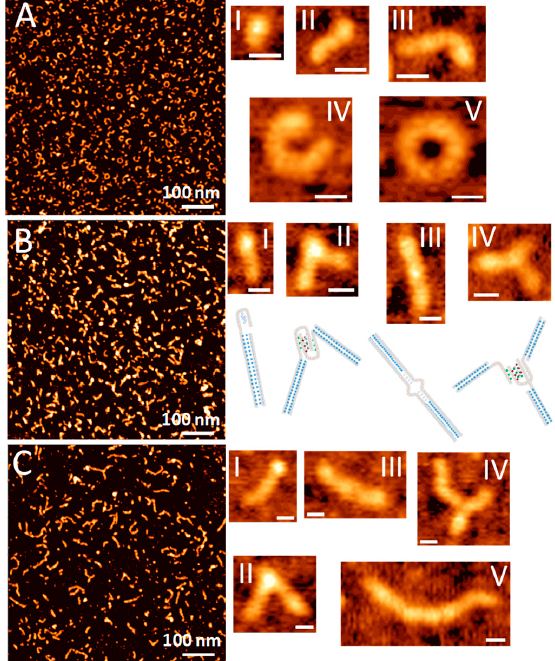
Figure 4. Atomic force microscopy (AFM) topography images of AgNC template with ( A ) C 12 , ( B ) SD9-OEC 12 , ( C ) SD9-BEC 12 . Insets show representative structures of the template sequences. Scale bar in all insets is 10 nm.